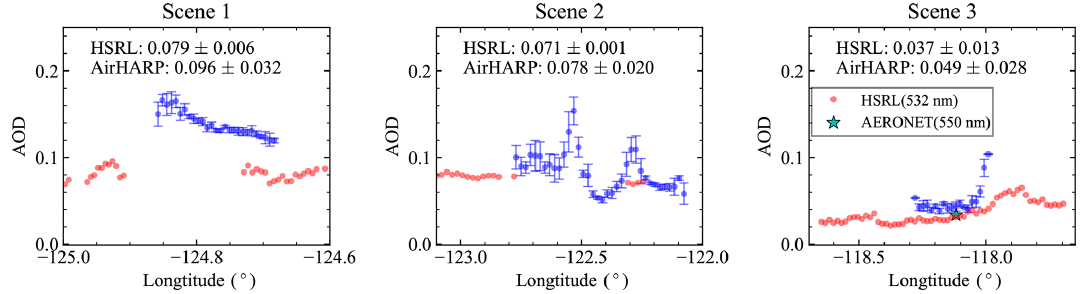
Figure 18. Comparison of the retrieved AOD (550nm) from AirHARP measurement with the AOD (532nm) from HSRL for Scene 1 to 3. The AOD (550nm) from the AERONET USC_SeaPRISM site is shown in Scene 3. The AirHARP retrieved AOD is averaged with 4 × 4 pixels (2 . 2km × 2 . 2km). The averaged AODs and their standard deviations for both AirHARP retrievals and HSRL products are provided in the text. Pixels with N v > 30 and χ 2 < 10 are considered.